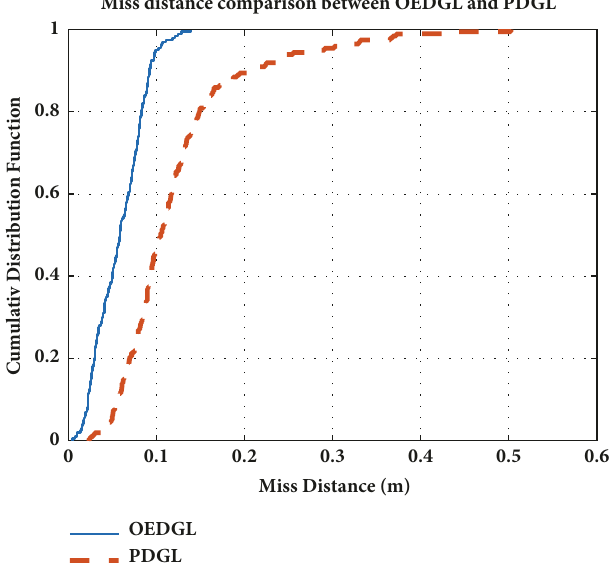
Figure 5: Miss distance CDF comparison between OEDGL and